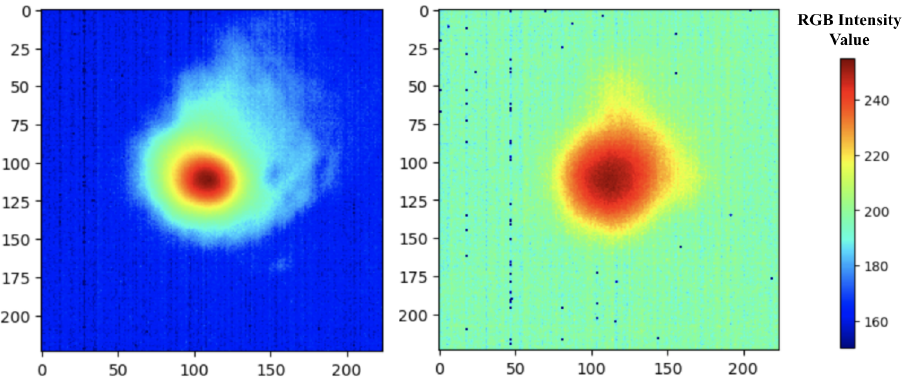
Figure 4. An example of a “good” pyrometer image ( left ) and a “bad” pyrometer image ( right